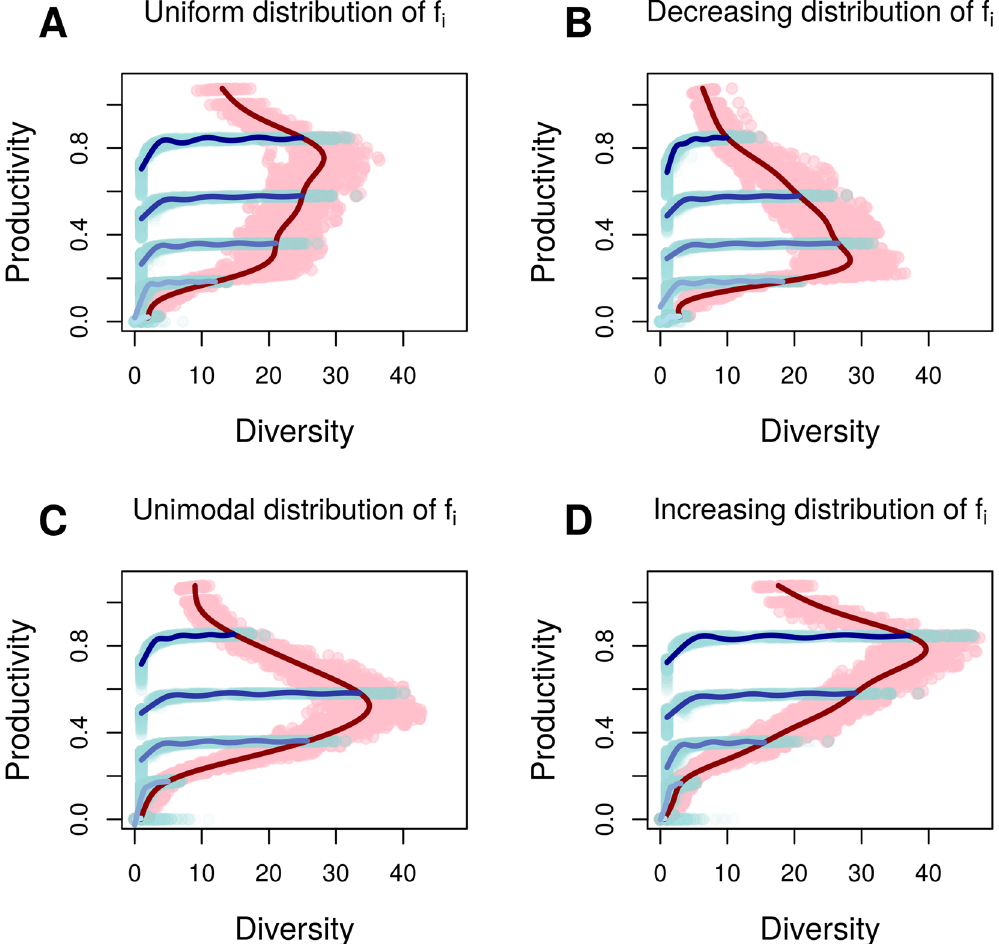
Figure 3. Diversity–productivity relationships for different distributions of trait f i . Pink points and associated modelled red curve represent the relationship along a resource gradient (increasing values of a and S). Light blue points and the associated blue curves represent simulations of BEF experiments, generated by subsampling a fixed number of species in the species pool, and this under different resource conditions (darker blue curves correspond to higher values of a and S). This figure illustrates the discrepancy between BEF experiments and observations of established communities: BEF experiments measure the increase in productivity as species diversity increases toward saturation (moving left to right along a blue line) at constant resource conditions, while observations of established or natural communities focus on gradient of soil resources (sampling a series of points on a red line). The BEF set-up produces systematic positive relationships between biodiversity and productivity, while the saturated state depends on soil resources in interaction with the structure of the species pool (the distribution of f i ). The figures reproduce expectations of Schmid 31 . Parameters used to generate this figure were: N = 125, b = 0.5, average of f i = 1.6, variability of f i = 1.2, average of l i = 2.05, variability of l i = 1.7, c i = 0.6. The assembly of 800 different species pools were simulated to generate this